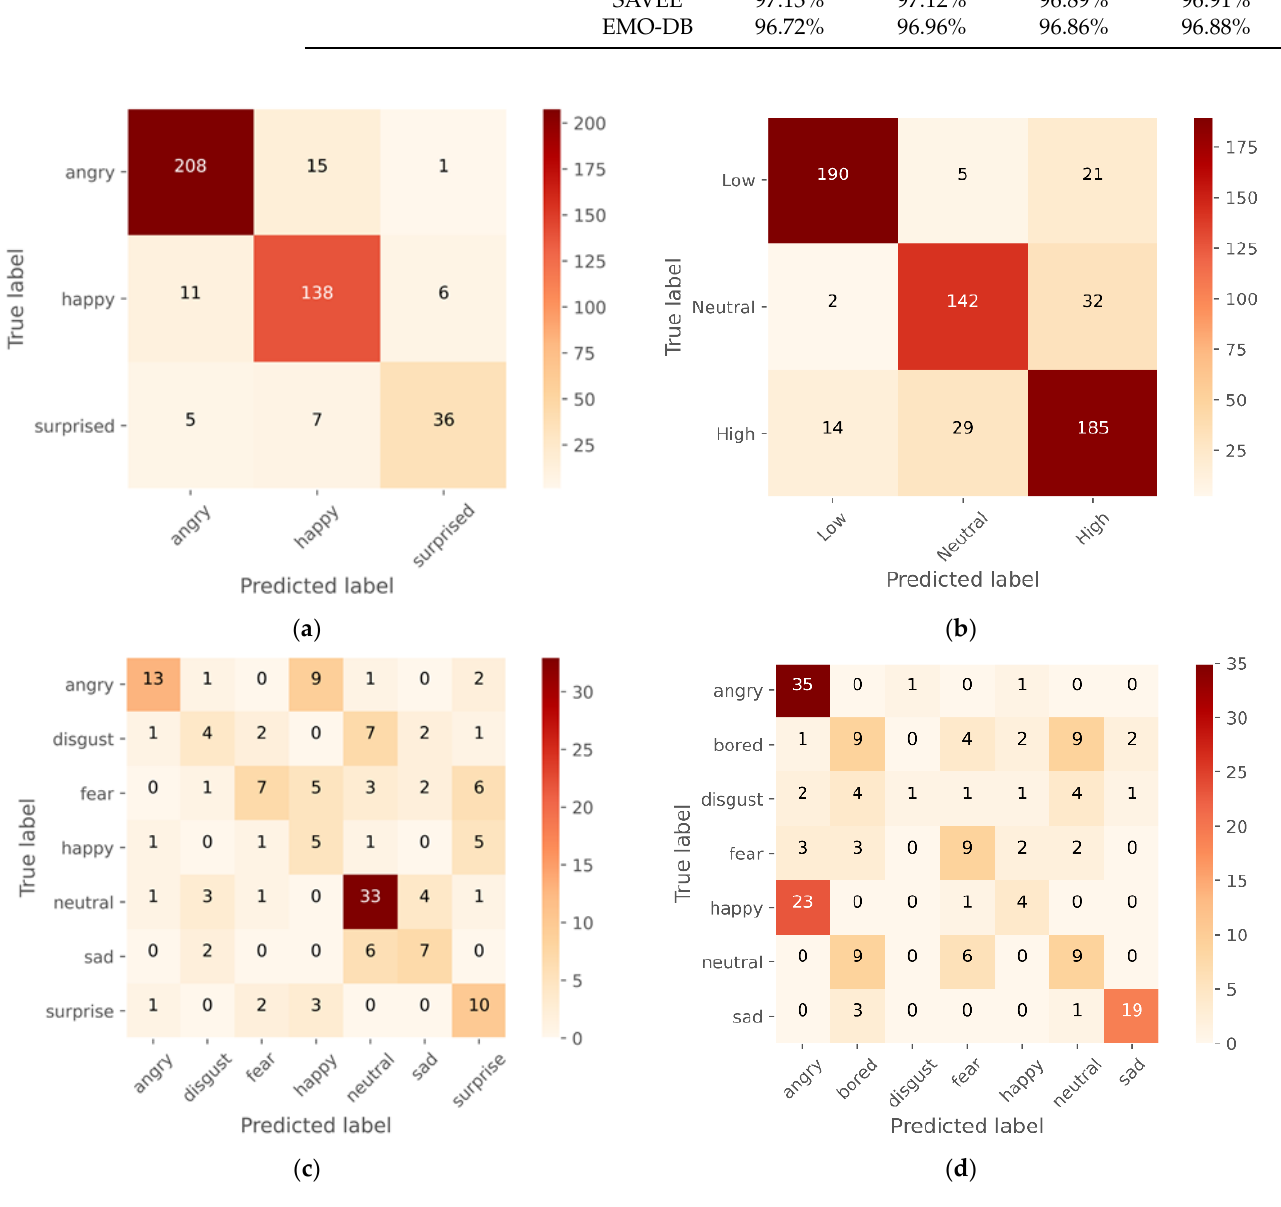
Figure 9. Confusion matrix of 2D CNN for the ( a ) ANAD, ( b ) BAVED, ( c ) SAVEE, and ( d ) EMO-DB